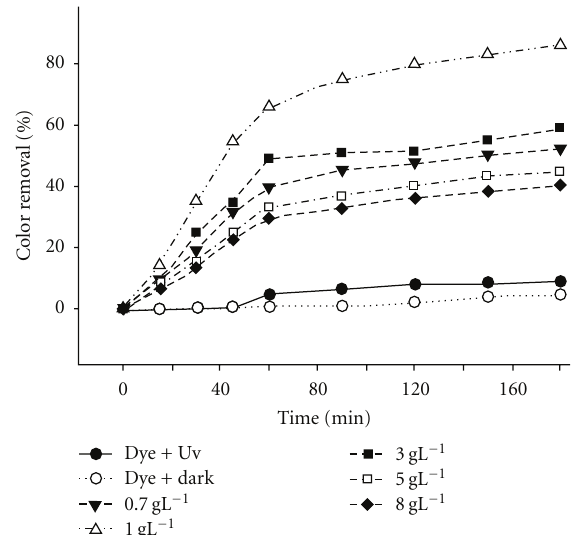
Figure 6: The e ff ects of photocatalyst concentration on the photo- decolorization of methyl green [methyl green] 0 = 40 mgL − 1 , pH = 5.2, T = 25 ◦ C.